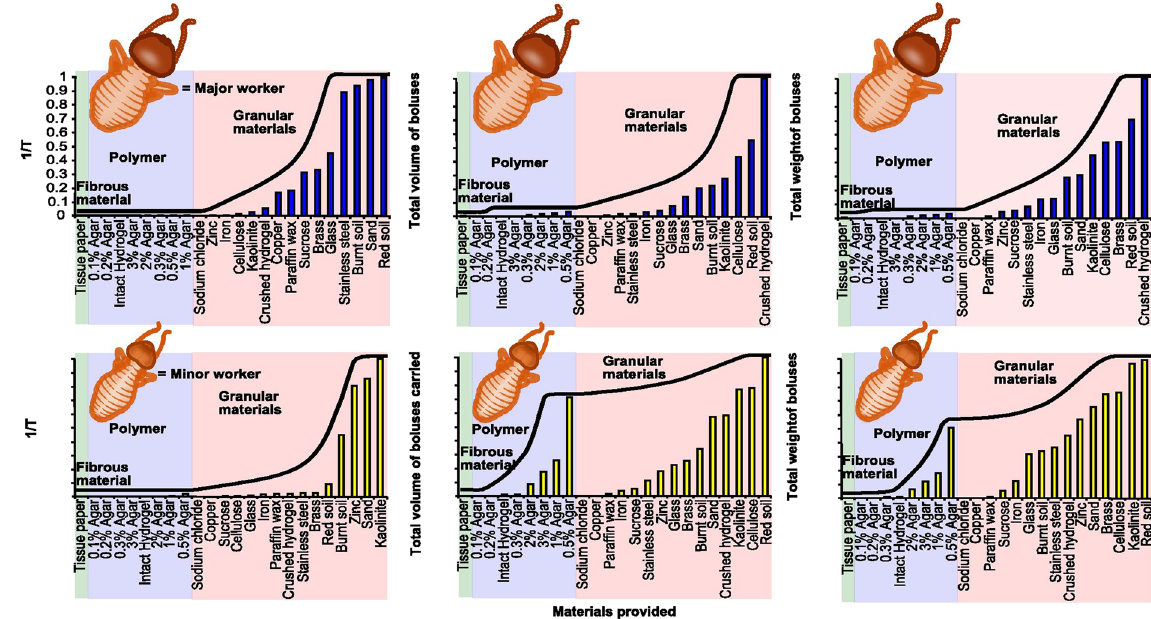
Figure 3. Ease of handling for different materials. Ease-of-handling parameters normalized for the maximum value in each